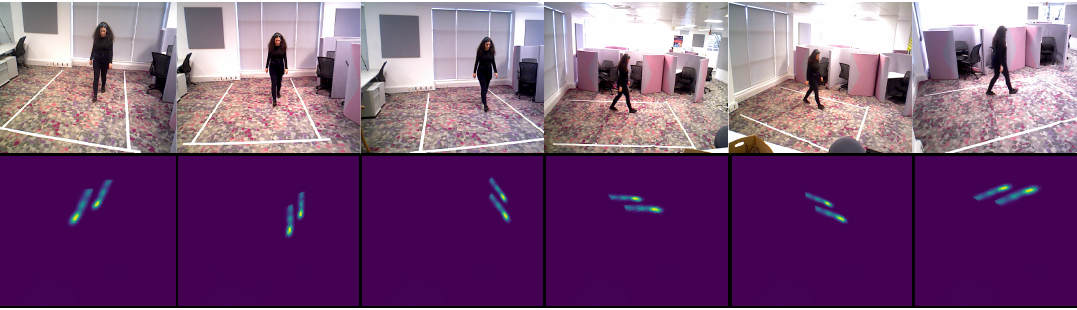
Figure 5. Walking example—all six views, and corresponding trajectory maps for feet. Table 3. VI-Net’s modules: { C 2 ( d × d , ch ) } × n : n 2D convolution filters with size d and ch